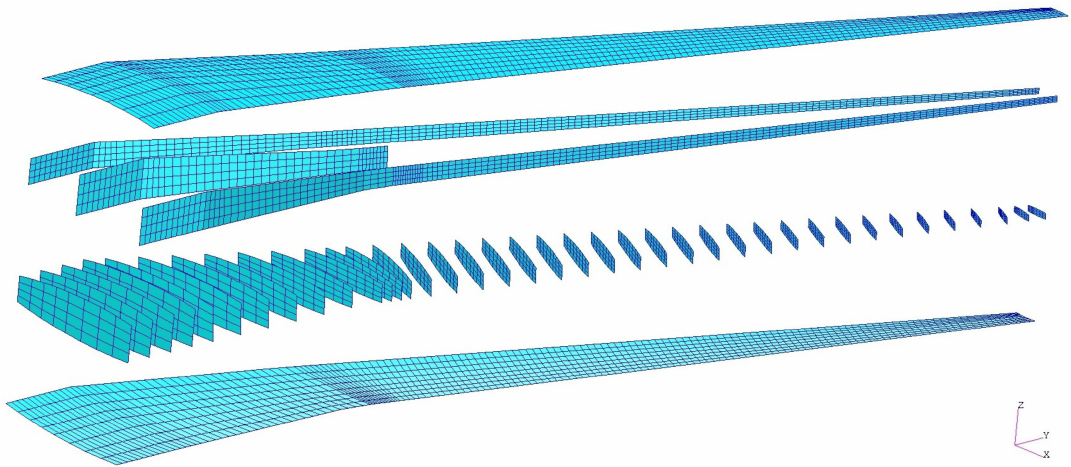
Figure 2. Structural topology of the wing-box for the main wing of the DLR-D250 GFEM (exploded